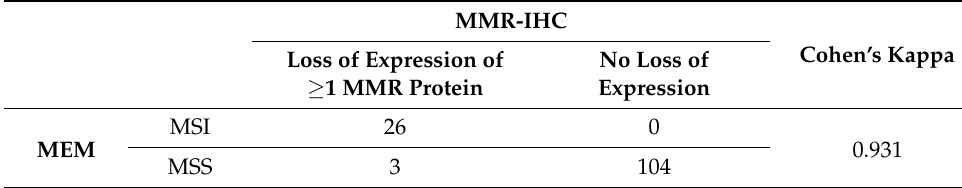
Table 4. Concordance between MEM results for MSI status and